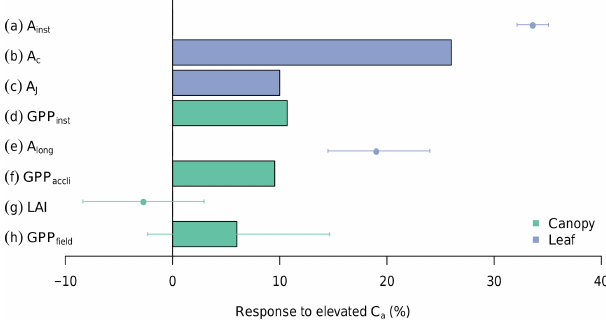
Figure 5. The modelled C a response of Rubisco-limited leaf photo- synthesis ( A c ) and RuBP-regeneration-limited leaf photosynthesis ( A J ) to leaf temperature ( T leaf ). The responses are calculated for temperatures during the 2013–2016 period. Parameters are as given in Table 1, except that V cmax , 25 and g 1 were assumed to be constant Figure 6. Distribution of average annual photosynthesis lim- ited by Rubisco activity and RuBP regeneration in bins of PAR (30µmolm − 2 s − 1 ). As calculated by MAESPA across all rings from 2013 to 2016. The histogram was constructed by calculating the photosynthesis (either limited by Rubisco or RuBP) falling into each bin for every 30min in the “ambient scenario”. These values were then summed to each year and ring and averaged over six rings and 4